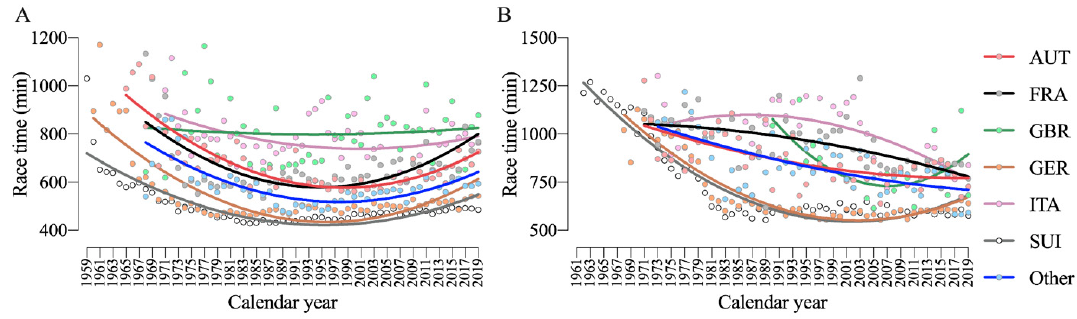
Figure 7. Performance trends of men ( A ) and women ( B ) by nationality throughout the years with second-order polynomial non-linear regressions. AUT = Austria, FRA = France, GBR = Great Britain, GER = Germany, ITA = Italy, SUI = Switzerland.